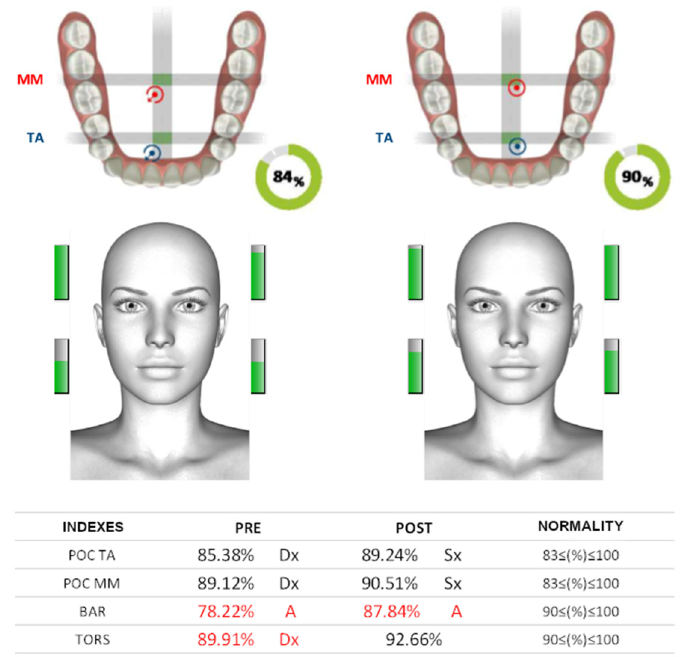
Figure 1. Example of recording electromyographic indices. In the graphic representation of the occlusal board, the position of the targets summarizes, visually, all the calculated occlusal indices and the intensity of the contraction of each muscle by green bars. Values that were outside the normal range are shown in red.